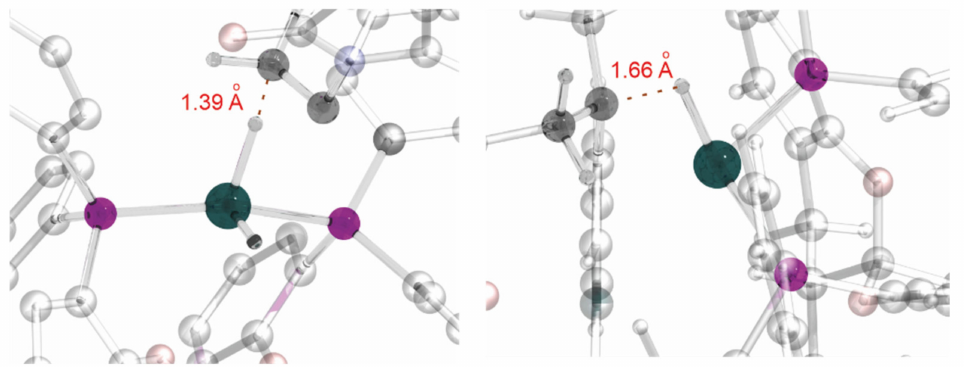
Figure 1. Partial view of the computed structures of the TS for migratory insertion ( left ) and reductive elimination ( right